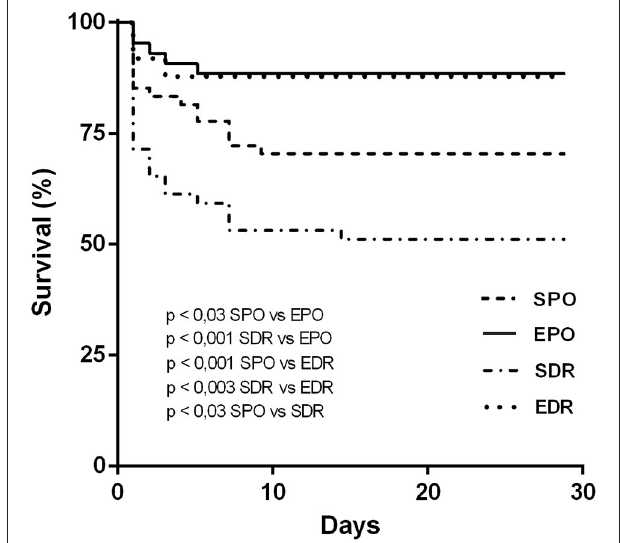
FIGURE 1 | Kaplan–Meier curves illustrating the probability of survival vs. time in animals from sedentary permanent occlusion (SPO), exercised permanent occlusion (EPO), sedentary delayed reperfusion (SDR), and exercised delayed reperfusion (EDR) groups. Differences were evaluated using the log-rank (Mantel-Cox)